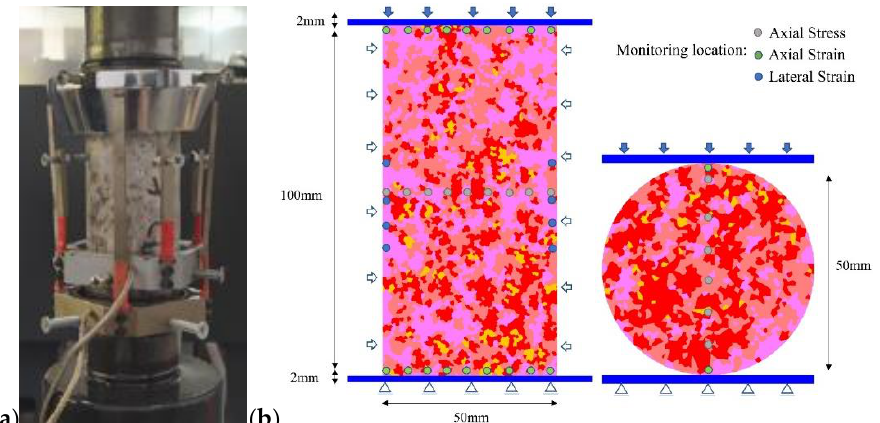
Figure 5. Boundary conditions of numerical model and layout of monitoring points. ( a ) Experimental sample monitoring system layout. ( b ) Layout of detection points for numerical simulation.